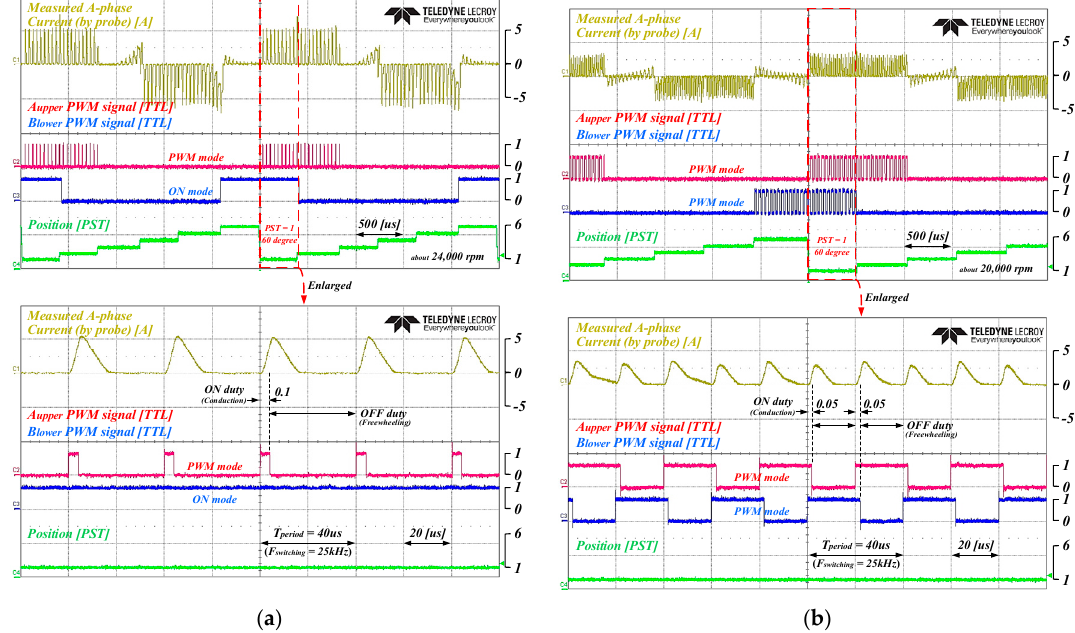
Figure 9. Experimental results on PWM patterns and current ripples: ( a ) H-PWM-L-ON method; and ( b ) H-PWM-L-PWM method.